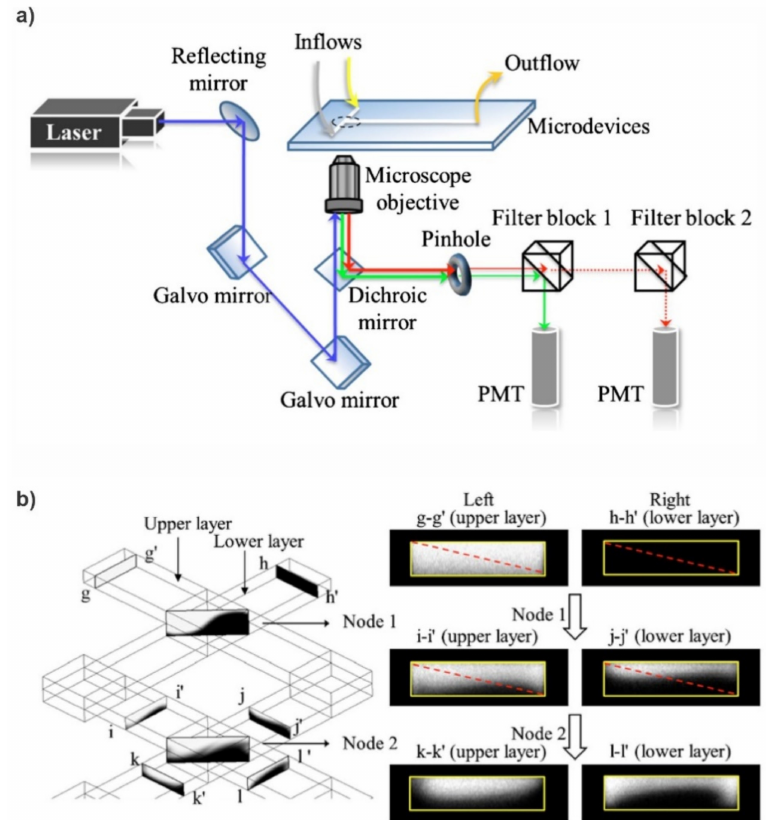
Figure 10. Confocal Fluorescence Microscope (CFM) for fluorescent imaging for mixing analysis. ( a ) Schematic diagram of the CFM system used by Fang et al., ( b ) schematics of the microfluidic mixer channel, and the cross-sectional fluorescent images depicting the progression of chaotic mixing along the mixer (reproduced with permission from Reference